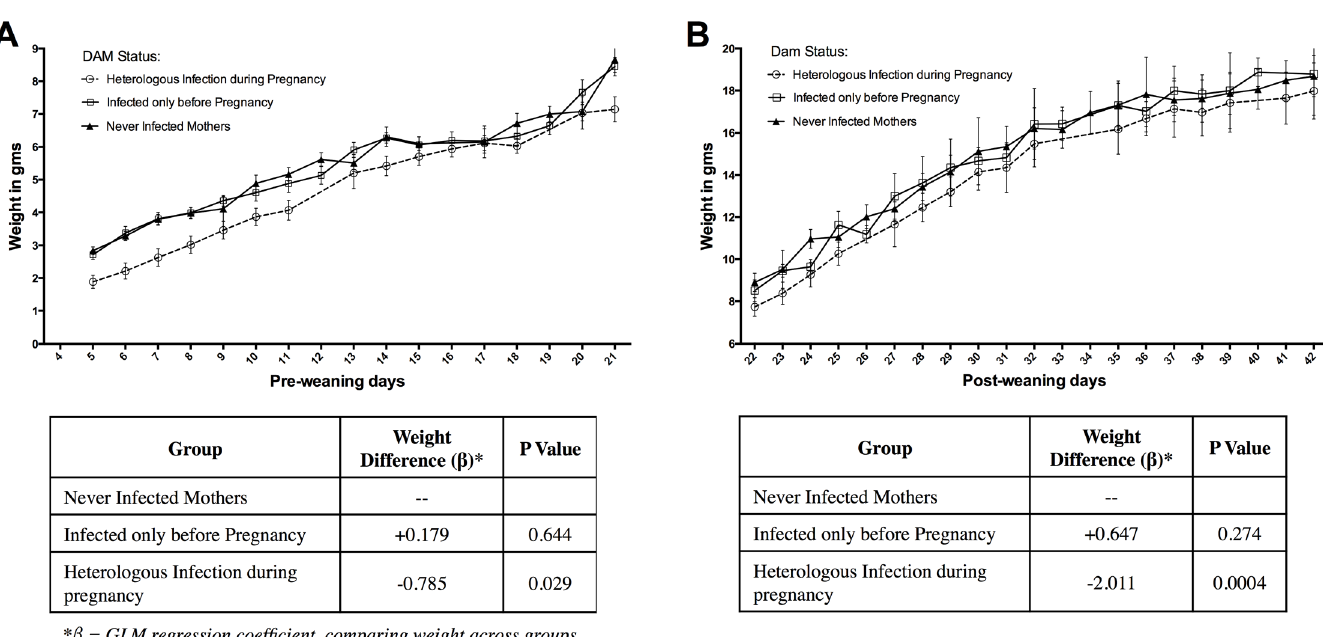
stained blood smears every 24 h. Differences in parasitemia between groups were evaluated